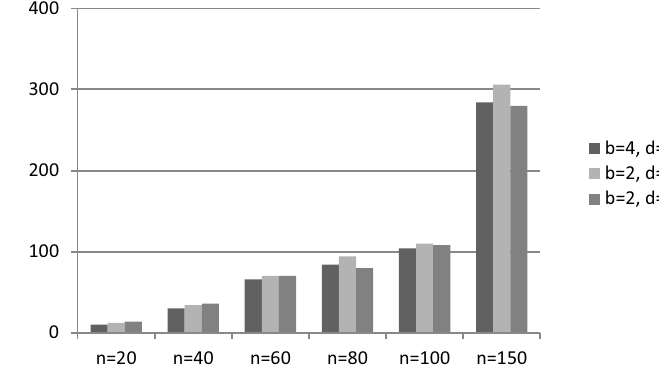
Fig. 1. In°uence of AIT parameters on